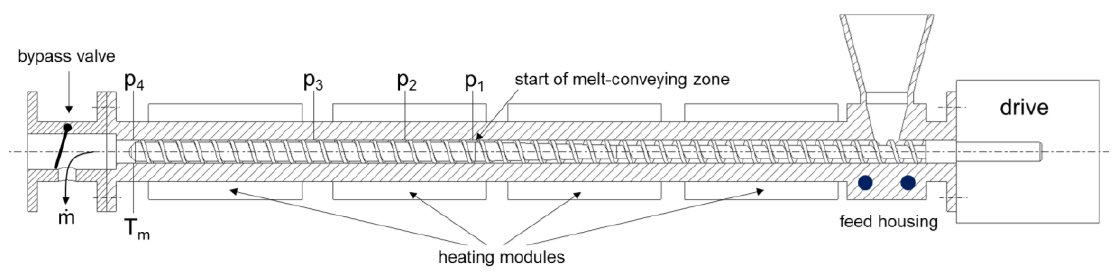
Figure 2. Schematic diagram of the plasticating single-screw extruder.